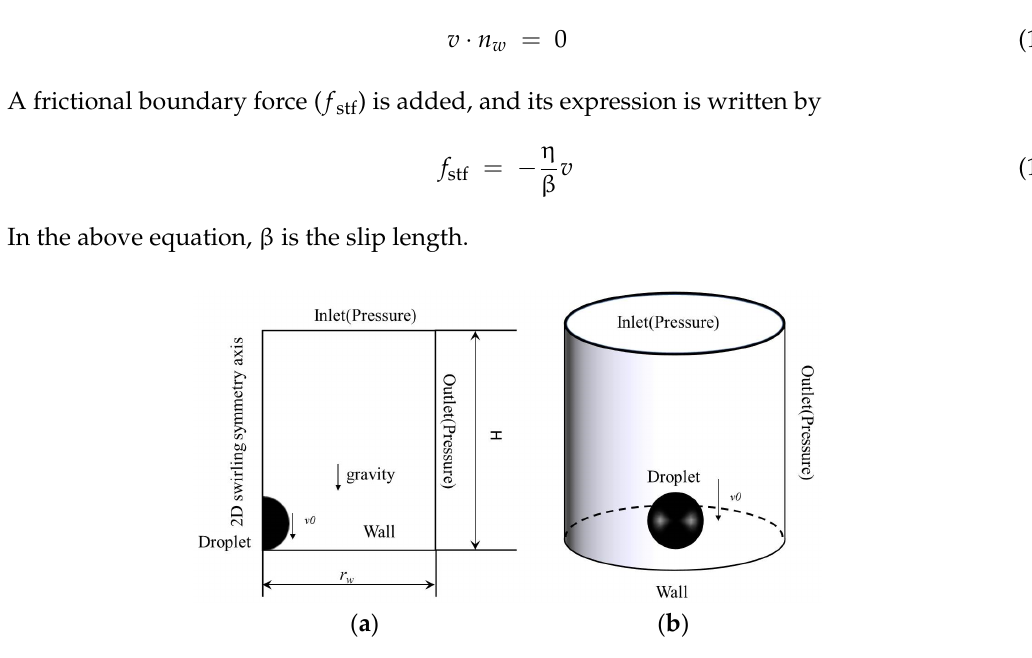
Figure 1. Schematic domain of the experiment for the water ‐ based paint droplet impact and spread. ( a ) 2D; ( b ) 3D.